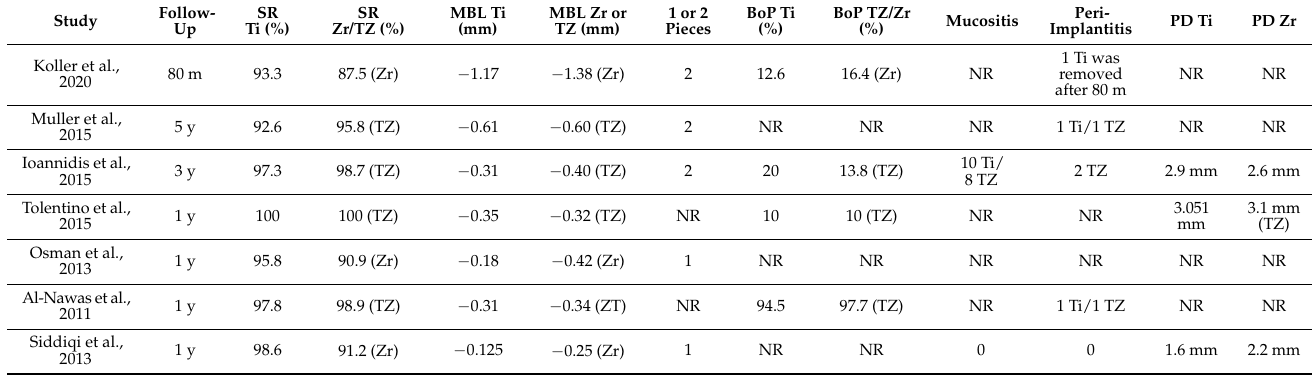
Table 3. Clinical data obtained from the included